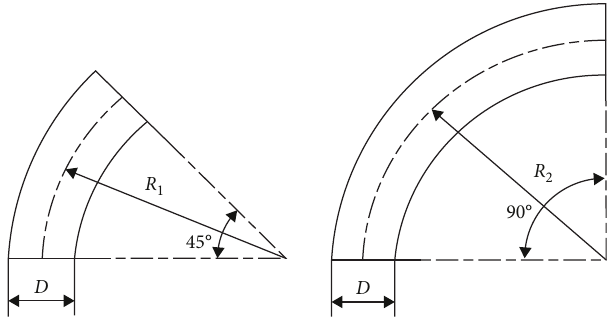
F IGURE 12: Diagram of elbow size.